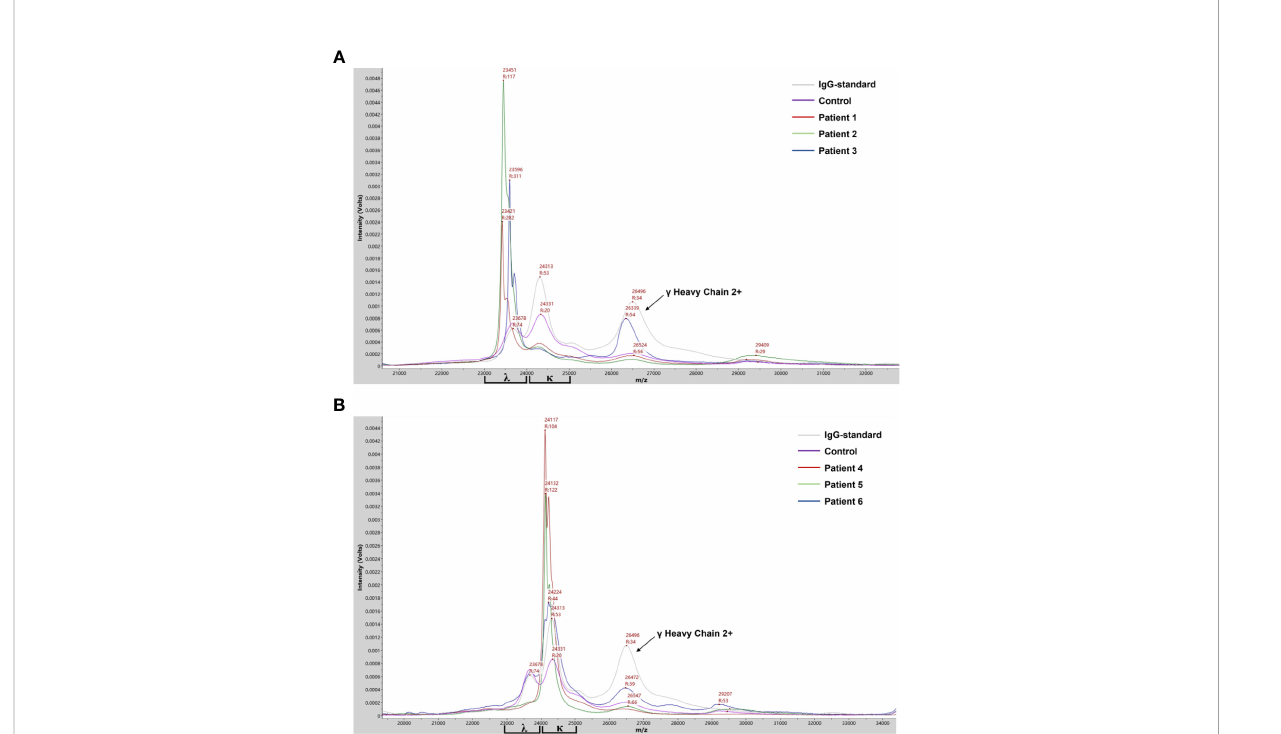
FIGURE 2 Mass spectra from patient serum samples revealed the clonal l (A) or k (B) light chain distribution of the M-proteins. Mass spectra from serum samples of IgG standard, health control and M-protein positive patients with l - (patient 1-3) or k - light chain (patient 4-6) were in different colors. Arrows indicated peaks correlated to the [M+2H] 2+ of l heavy